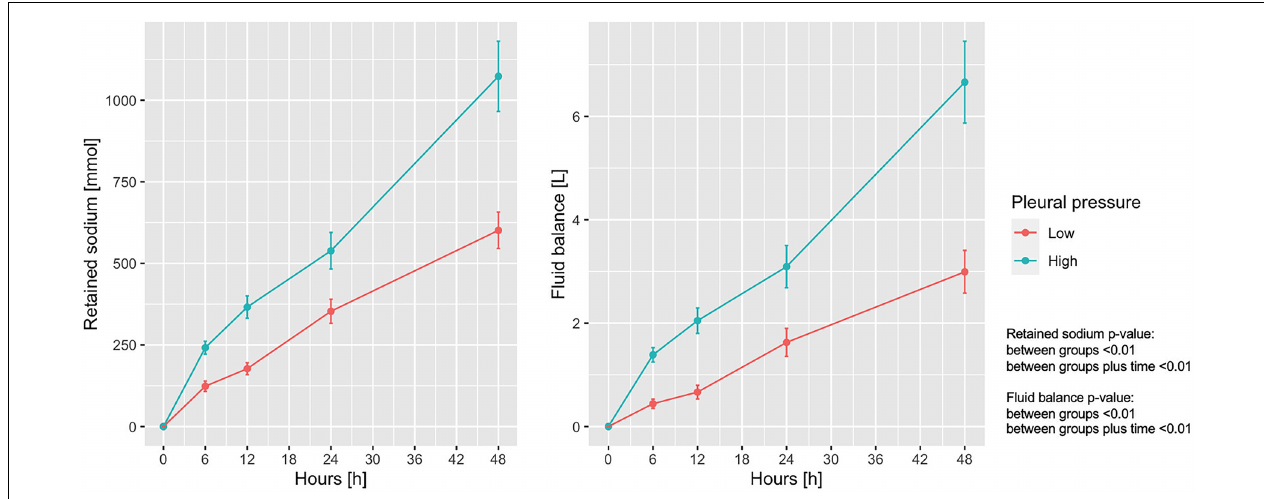
FIGURE 2 | Trend of retained sodium and fluid balance according to pleural pressure. Line-plot over the 48 h of the experiment. Statistic: linear mixed effects model. Retained sodium: data available in 78 animals at 0 h and in 60 at 48 h (36 in low-pressure group and 24 in the high-pressure group). Fluid balance: data available in 78 animals at 0 h and in 62 at 48 h (38 in low-pressure group and 24 in the high-pressure group).